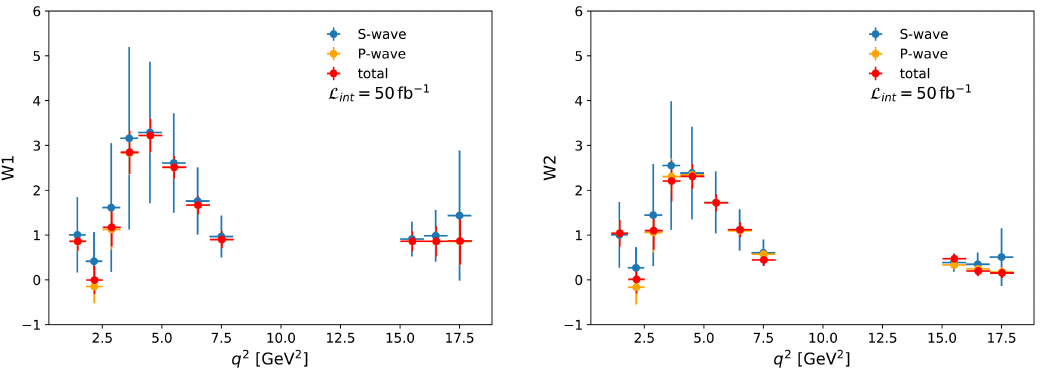
Figure 25 . Pseudo-expriment results for (left) W 1 and (right) W 2 with the expected LHCb Run 4 data set of 50 fb − 1